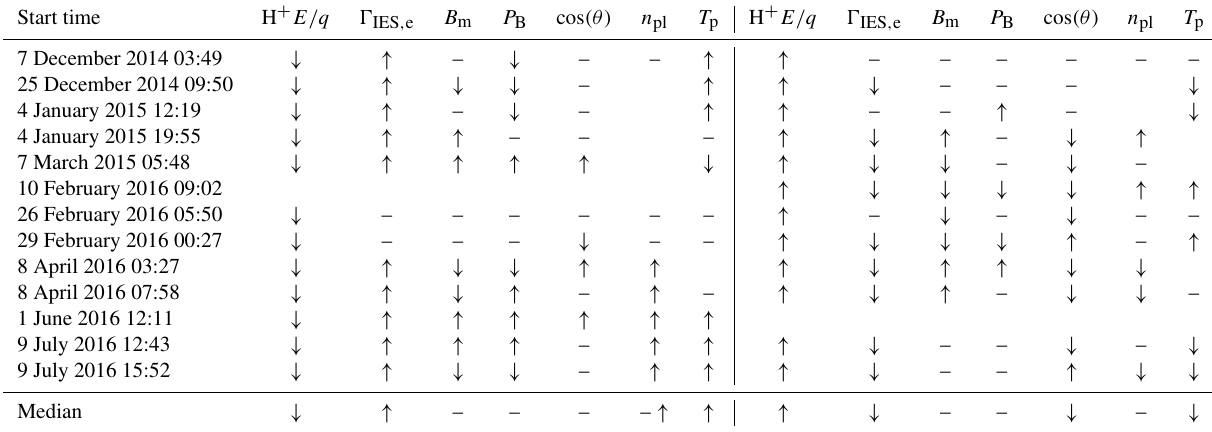
Table 1. List of 13 events chosen for a more detailed study and list of parameter changes when crossing from upstream to downstream (inward, left) and from downstream to upstream (outward, right). The last line summarizes events by giving a median change. Missing symbols indicate that no data were available, and “–” indicates no